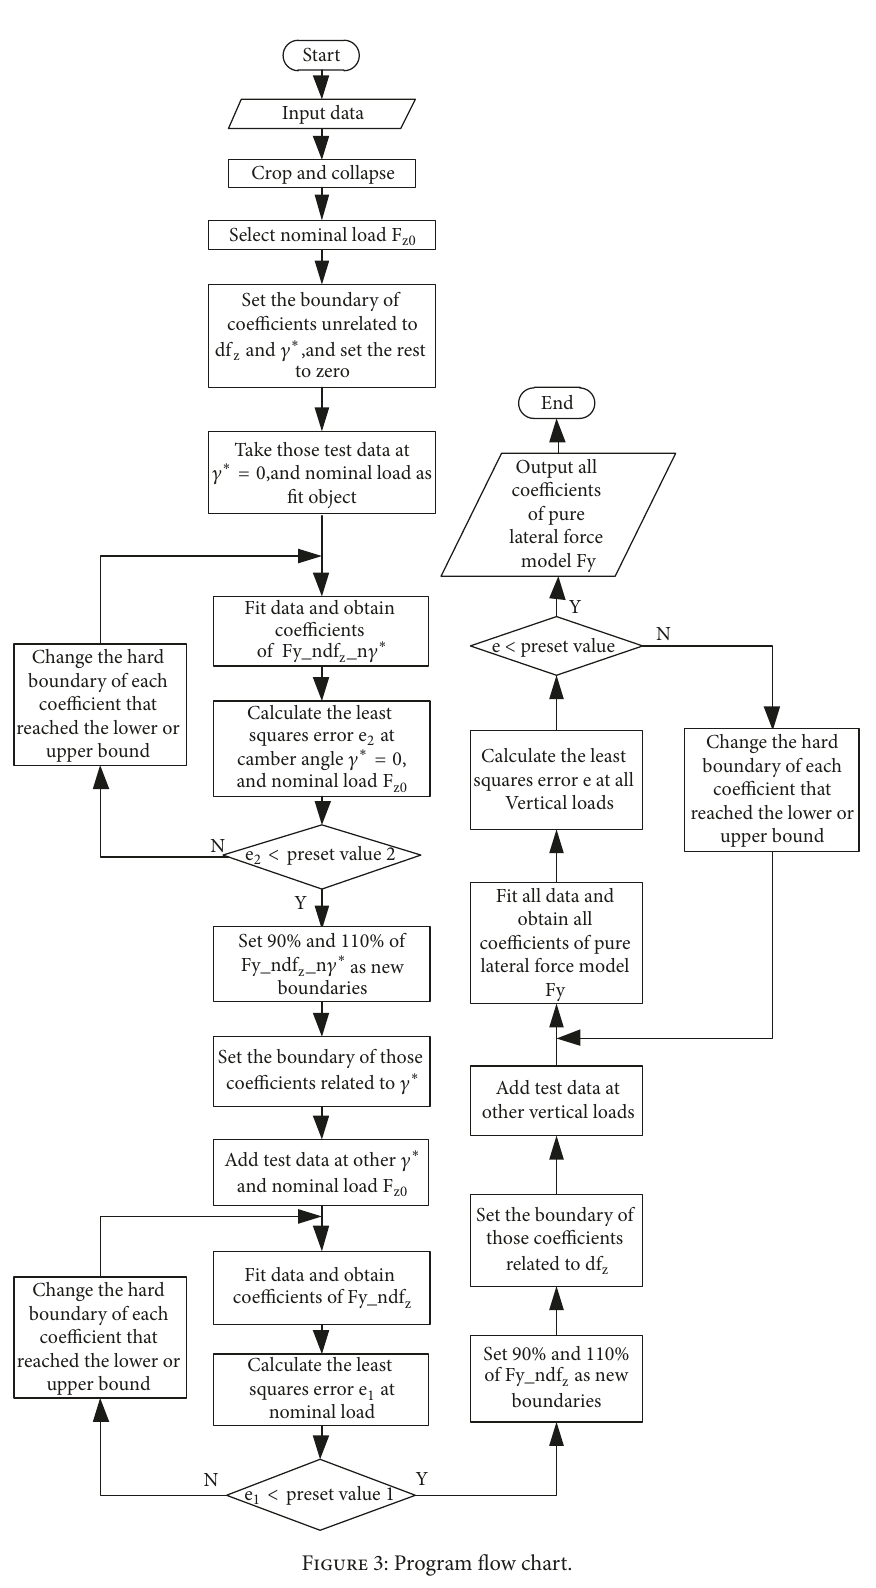
Figure 3: Program flow